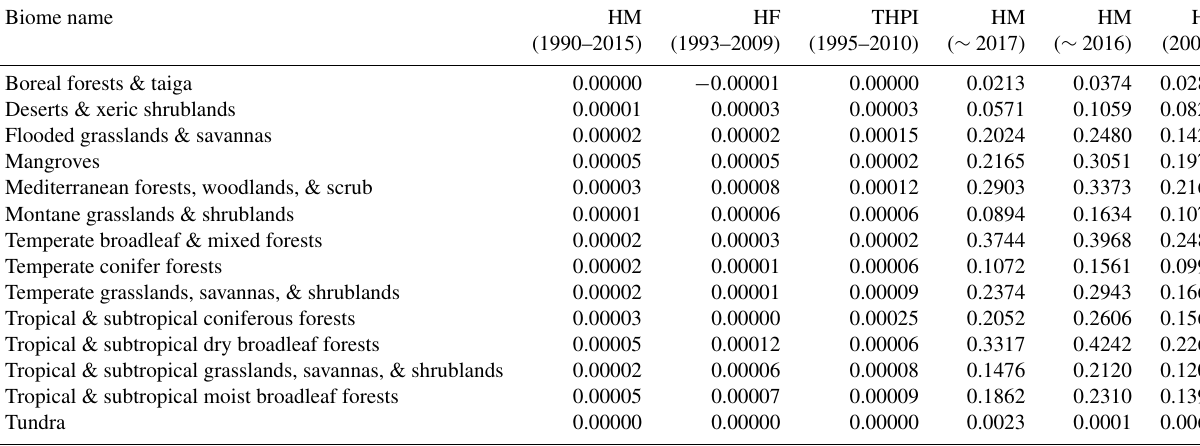
Table 7. Summary of results by biome, comparing trends using the mean annualized difference for the human modification ( H mad ), human footprint (HF mad ; Venter et al., 2016), and the mean temporal human pressure index (THPI mad ; Geldmann et al., 2019) score. Also provided are estimates of the proportion of terrestrial lands modified as estimated from Kennedy et al. (2018, 2019b; H1k) and the HF (score was max-normalized to rescale to 0–1). The THPI dataset characterizes only change, and so estimates of the proportion of lands modified in 2010 could not be provided. Mean annualized mean difference is calculated as the mean value across the continents and globally of the difference in H values divided by the number of